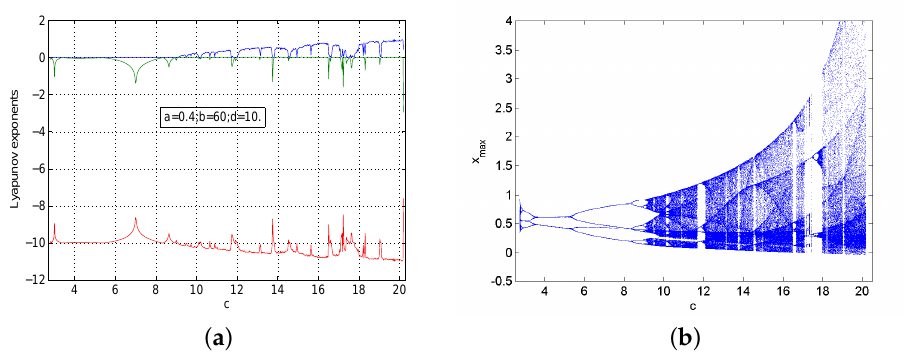
Figure 6. The Lyapunov exponents spectrum and the bifurcation diagram of system (1) with ( a , b , d ) = ( 0.4,60,10 ) and 2.7 < c < 20.2 at the initial values ( 0.01,0.01,0.01 ) T : ( a ) Lyapunov exponents; ( b ) bifurcation diagram.